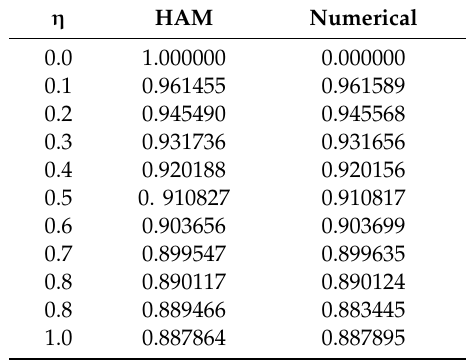
Table 3. The assessment of the HAM and ND-Solve for f (cid:48) ( η ) .